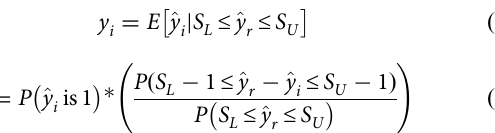
Fig. 3 Autoencoders and DiffNets can both compress protein structures and then reconstruct them. a Reconstruction error plots showing the root- mean-square deviation (RMSD) between a protein structure from simulation and the corresponding protein structure generated by unsupervised autoencoders (yellow) or DiffNets (blue). One of every ten structures from wild-type and M182T simulation data was used ( n = 65,210) and the standard deviation is shown with error bars. b Structure representing the difference between a structure generated by the DiffNet (blue) vs. the actual conformation from simulation (gray) when training with 3